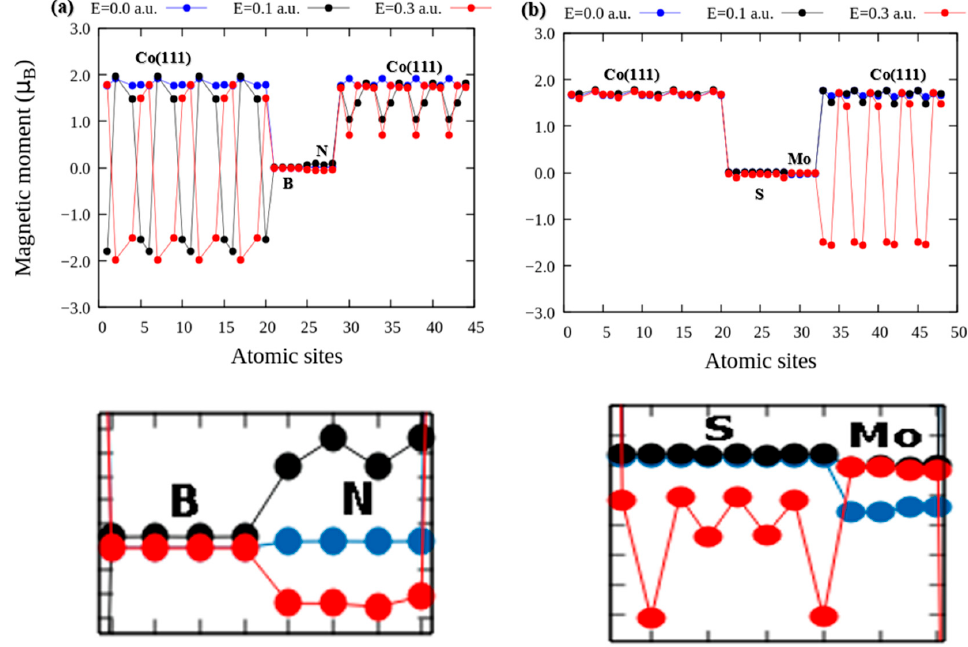
Figure 2. Magnetic spin moments in ( µ B) per atomic sites ( a ) Co(111)/hBN/Co(111), and ( b ) Co(111)/MoS 2 /Co(111) interfaces. The different colors (blue, black, and red) show the values of the electric field in (a.u.) as a function of the magnetic moment. The green double arrow under and above refers to the atoms at specific positions. The corresponding lower panels represent the zoomed-in image of the central region of the magnetic tunnel junction to show distributions of localized magnetic moments in monolayer hBN and MoS 2 , respectively.